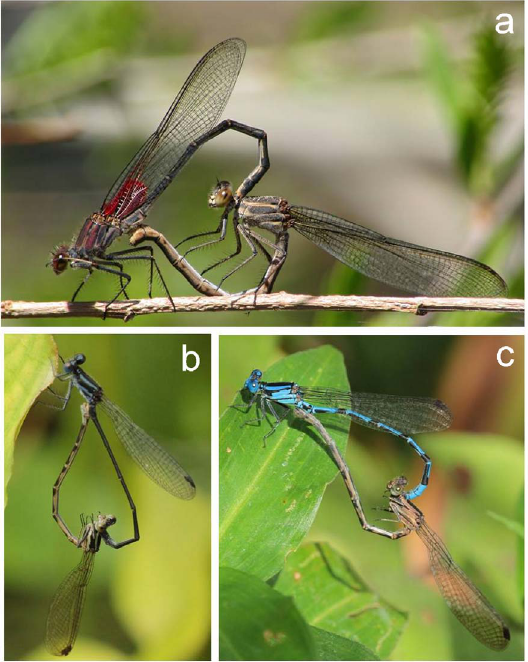
Figure 1. The sicker sex. Three study subjects: a) H. americana (photo courtesy, Pierre Deviche); b) Argia pulla ; and c) A. extranea (photo courtesy for both Argia species, Benoit Guillon). Males appear above, females